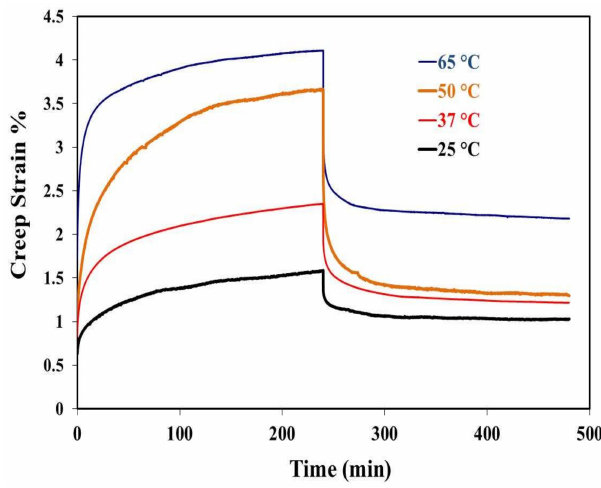
Figure 4. Effects of temperature on the creep behavior of porous polyethylene.